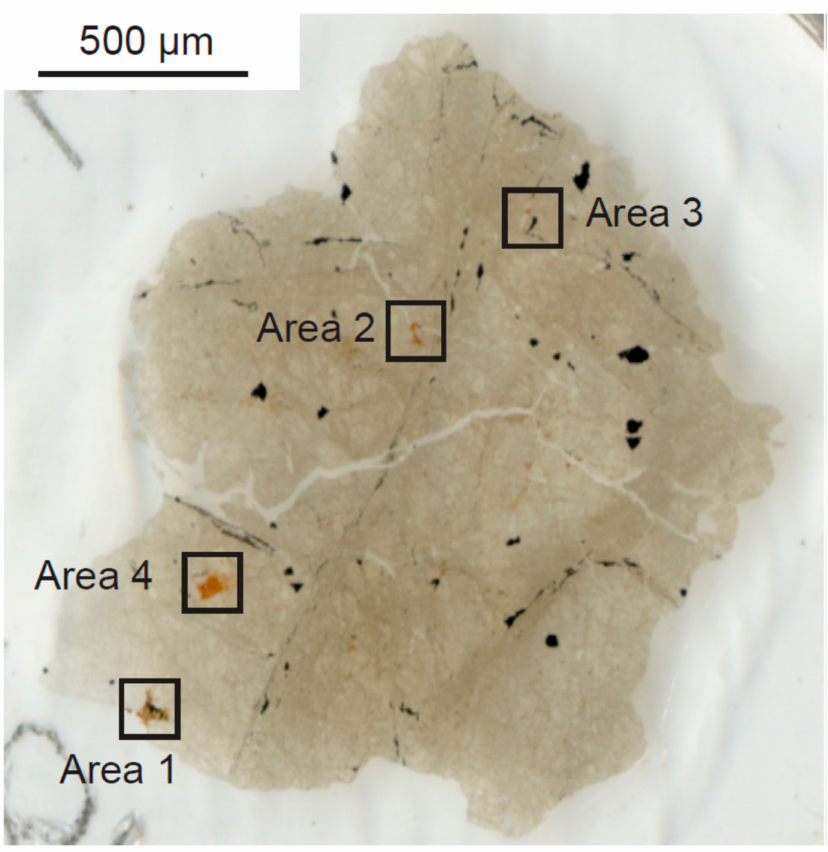
Figure 1. Photograph (plane-polarized light) of the thin section of Alan Hills (ALH) 84001 used in this study. Boxes identify the X-ray fluorescence (XRF) mapping areas shown in Figure 2.